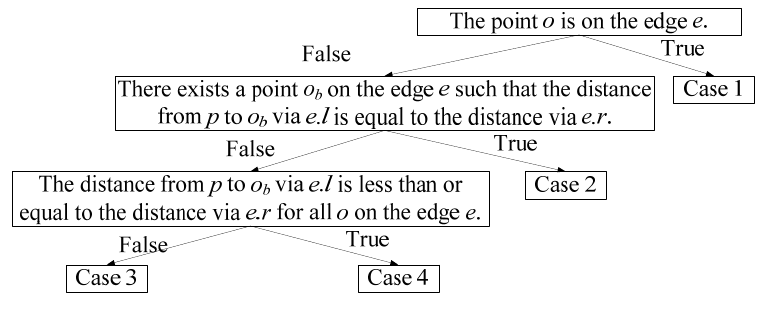
Figure 3. Decision tree for dist ( p , o